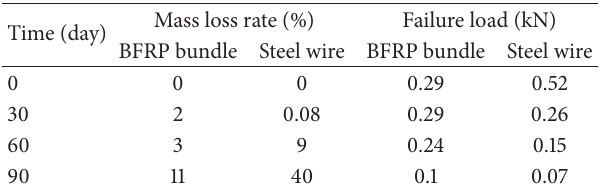
Table 5: Mass loss rate and failure load of bundles after being placed in NaCl